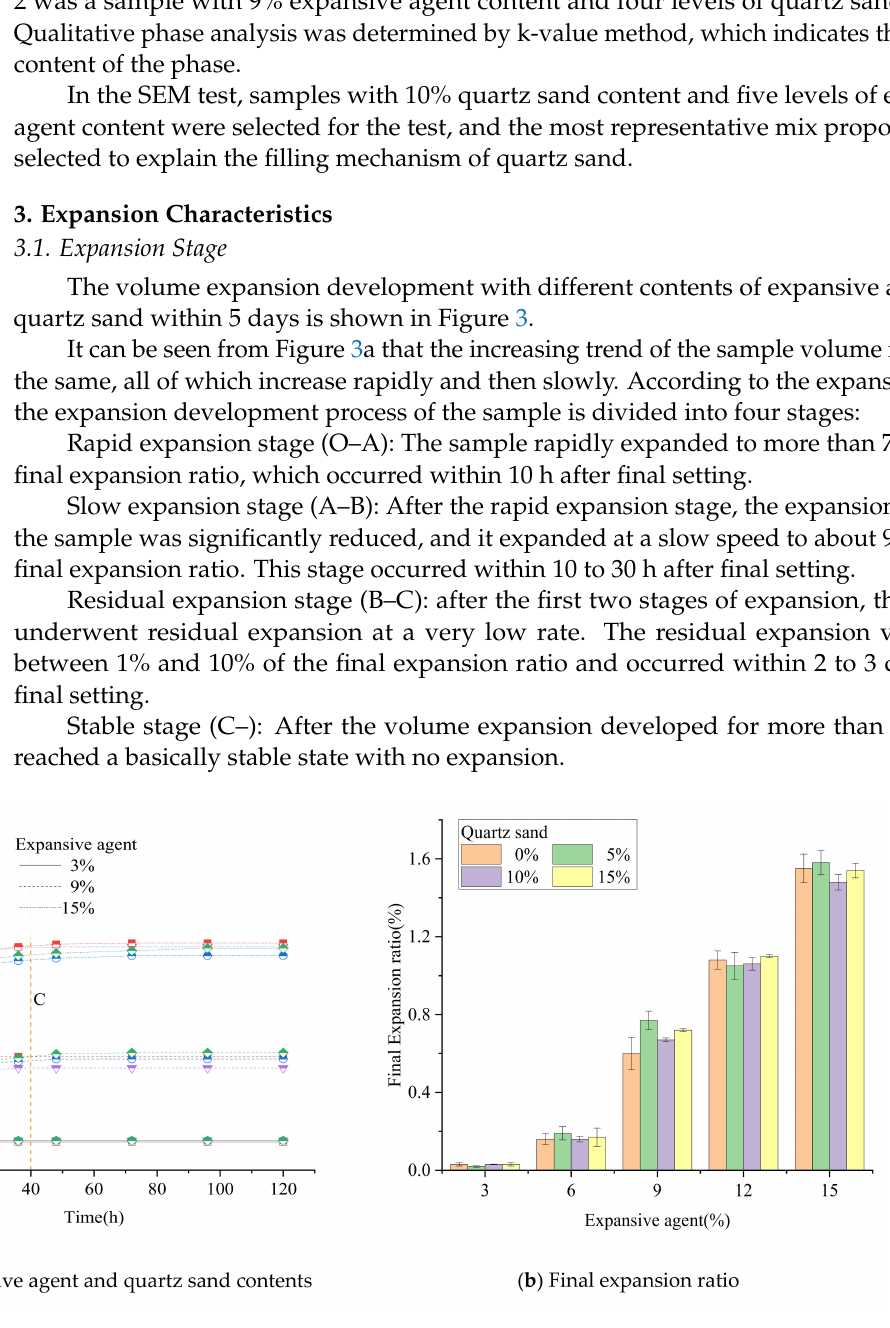
Figure 3. Expansion development of expansive grout